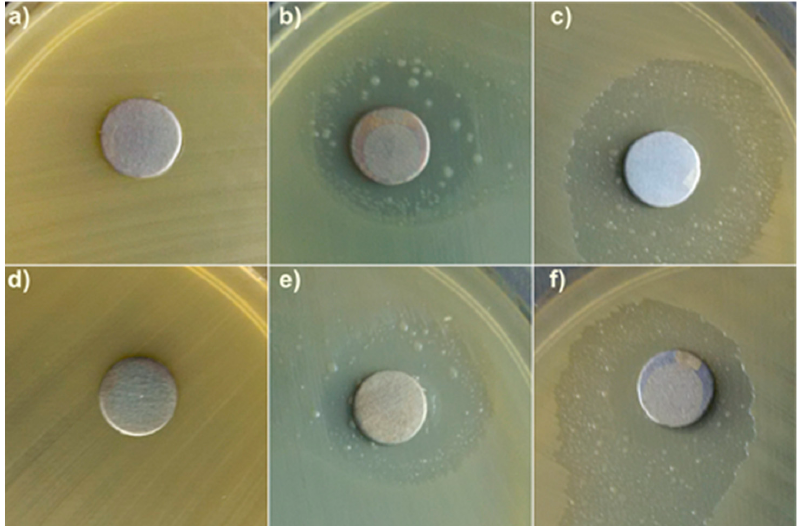
Figure 10. Qualitative assay of the inhibitory activity of Ag:HAp-S1 and Ag:HAp-S2 at time T0 (Ag:HAp-S1_T0 ( b ) and Ag:HAp-S2_T0 ( c )) and T6 (Ag:HAp-S1_T6 ( e ) and Ag:HAp-S2_T6 ( f )) composite layers against Candida albicans ATCC 10231 microbial strain; Ti discs were used as control ( a , d